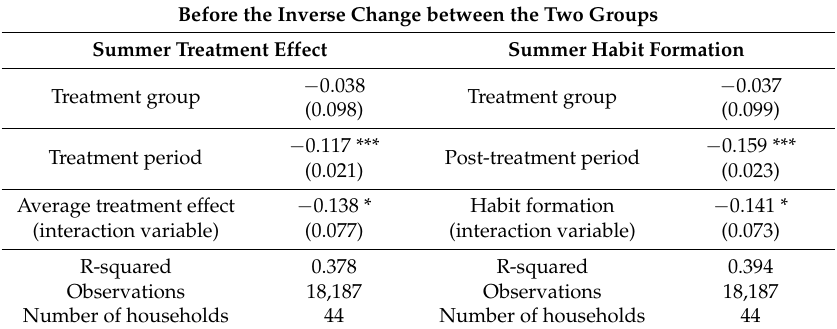
Table 5. Summer experiment’s regression